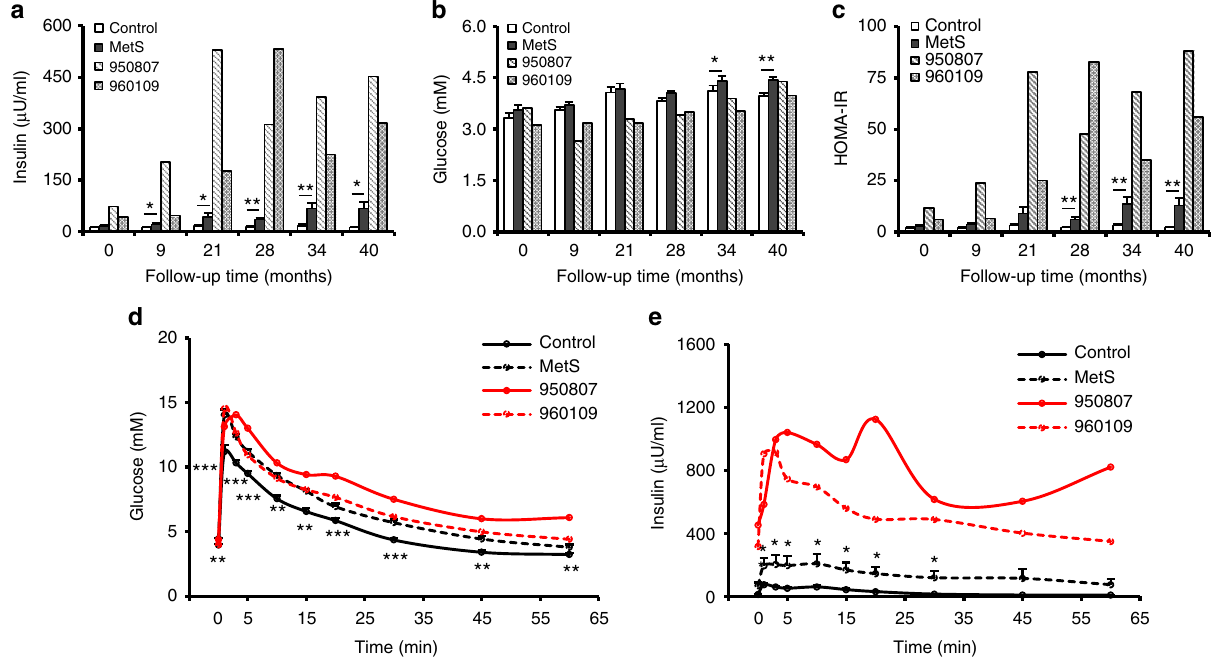
Fig. 1 Changes of glucose and insulin levels in hyperinsulinemic monkeys. a Fasting plasma insulin levels of control, MetS, and hyperinsulinemic monkeys in follow-up studies. b Fasting plasma glucose levels of control, MetS, and hyperinsulinemic monkeys in follow-up studies. c Homeostasis model assessment of insulin resistance (HOMA-IR) of control, MetS, and hyperinsulinemic monkeys in follow-up studies. d Glucose excursion of control, MetS, and hyperinsulinemic monkeys during IVGTT at 40 months of follow-up studies. e Insulin excursion of control, MetS, and hyperinsulinemic monkeys during IVGTT at 40 months of follow-up studies. * p < 0.05, ** p < 0.01, *** p < 0.001, control vs MetS (Control, n = 16; MetS, n = 17). All data are represented as mean ± SEM, the signi fi cant difference between groups was assessed by the Student ’ s t